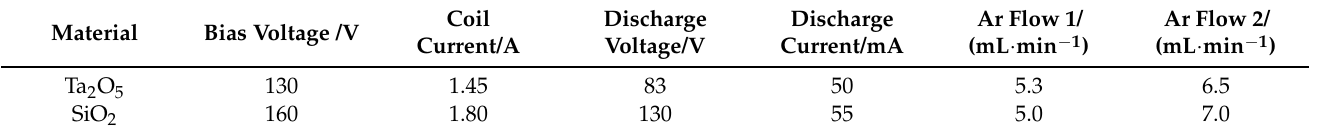
2 O 5 and SiO 2